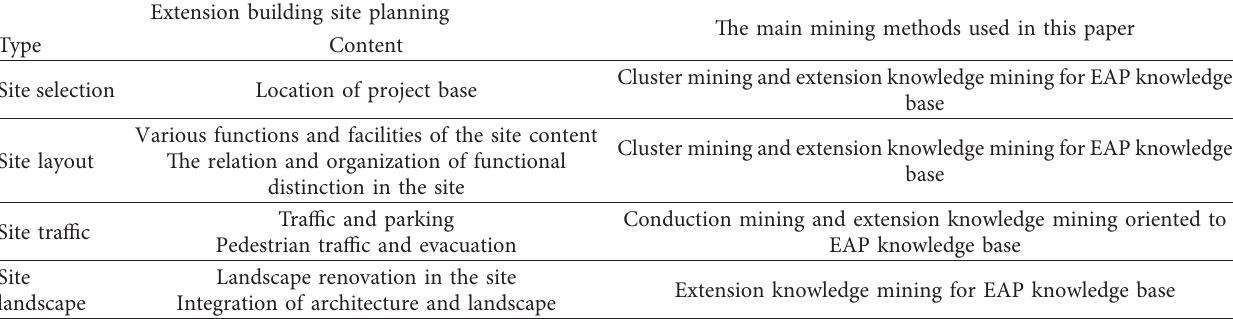
Table 2: Extension mining method for extension building site planning.